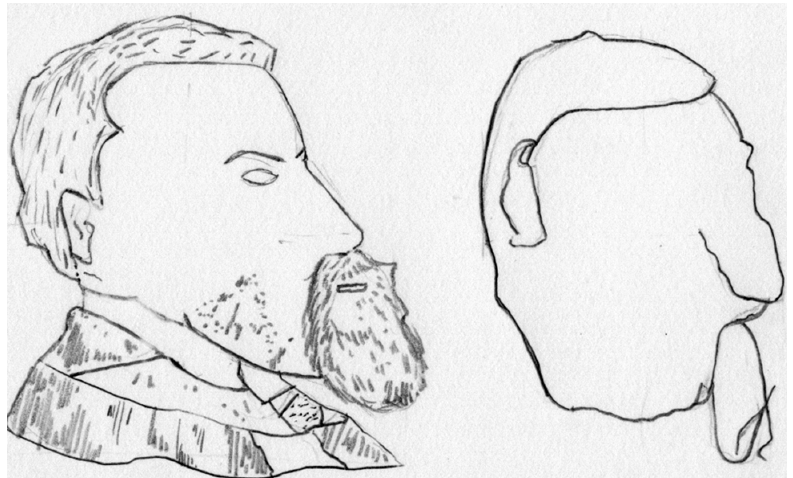
Figure 3. Pencil scheme from Luria (1973) of the drawings produced by a patient with the inability to draw a picture of a named object. A. Drawing done with patient looking at a model. B. Drawing done by the same patient without looking at a model – drawn only from